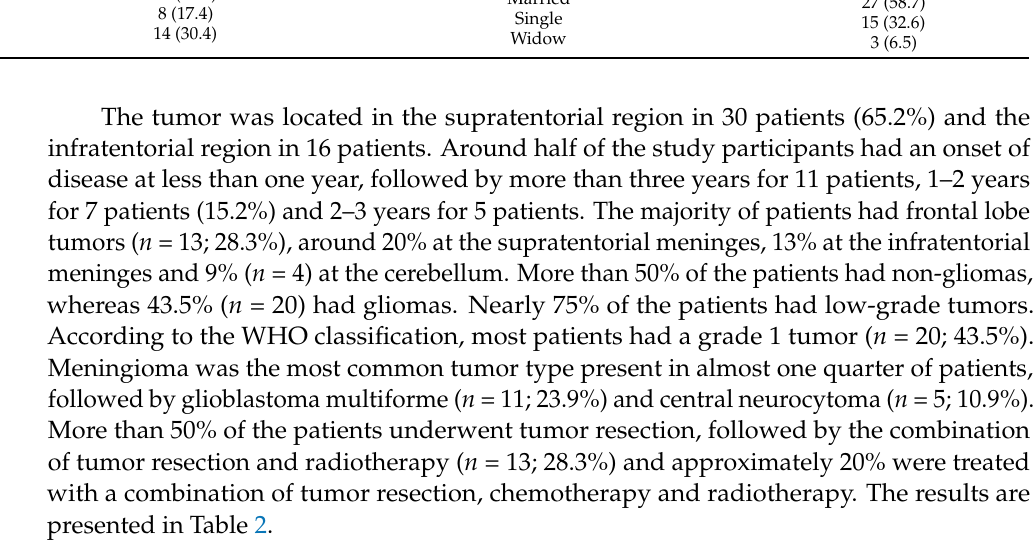
Table 2. Tumor characteristics and distribution of gliomas and non-gliomas among WHO tumor grades and tumor